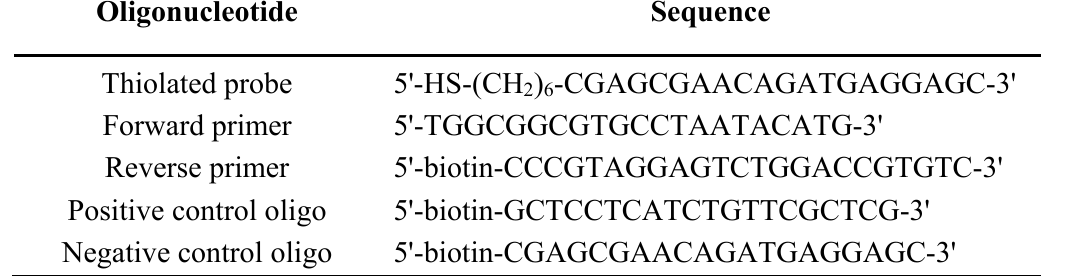
Table 1. Sequences of oligonucleotides used in this